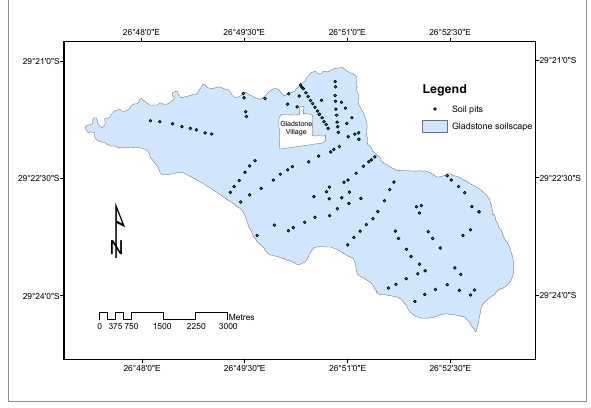
Map showing the Gladstone soilscape and the distribution of soil pits within this